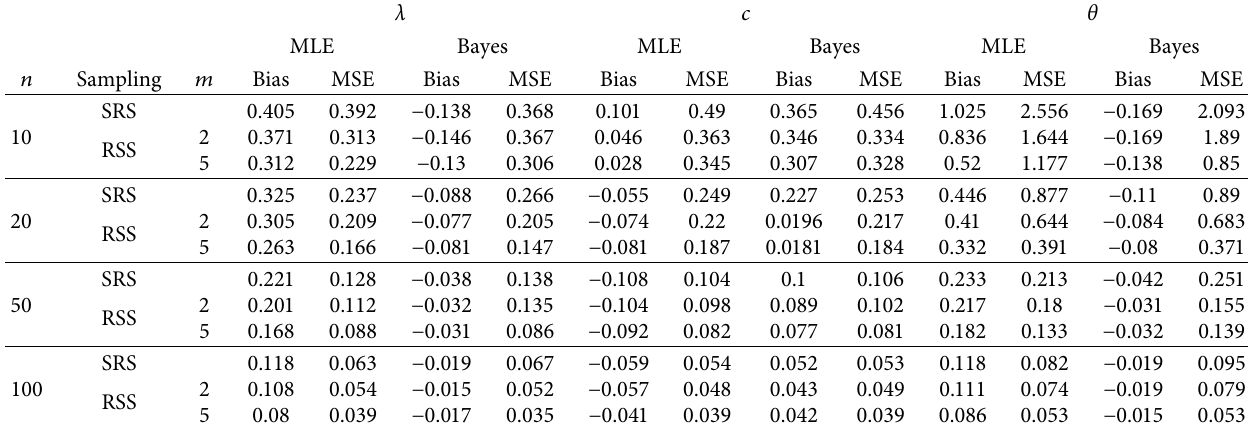
Table 4: Bias and MSE of the Bayes estimates obtained using DE-MCMC and Lindely methods under RSS and SRS for different sample sizes and different set sizes when λ � 0 . 5, c � 0 . 5, and θ �